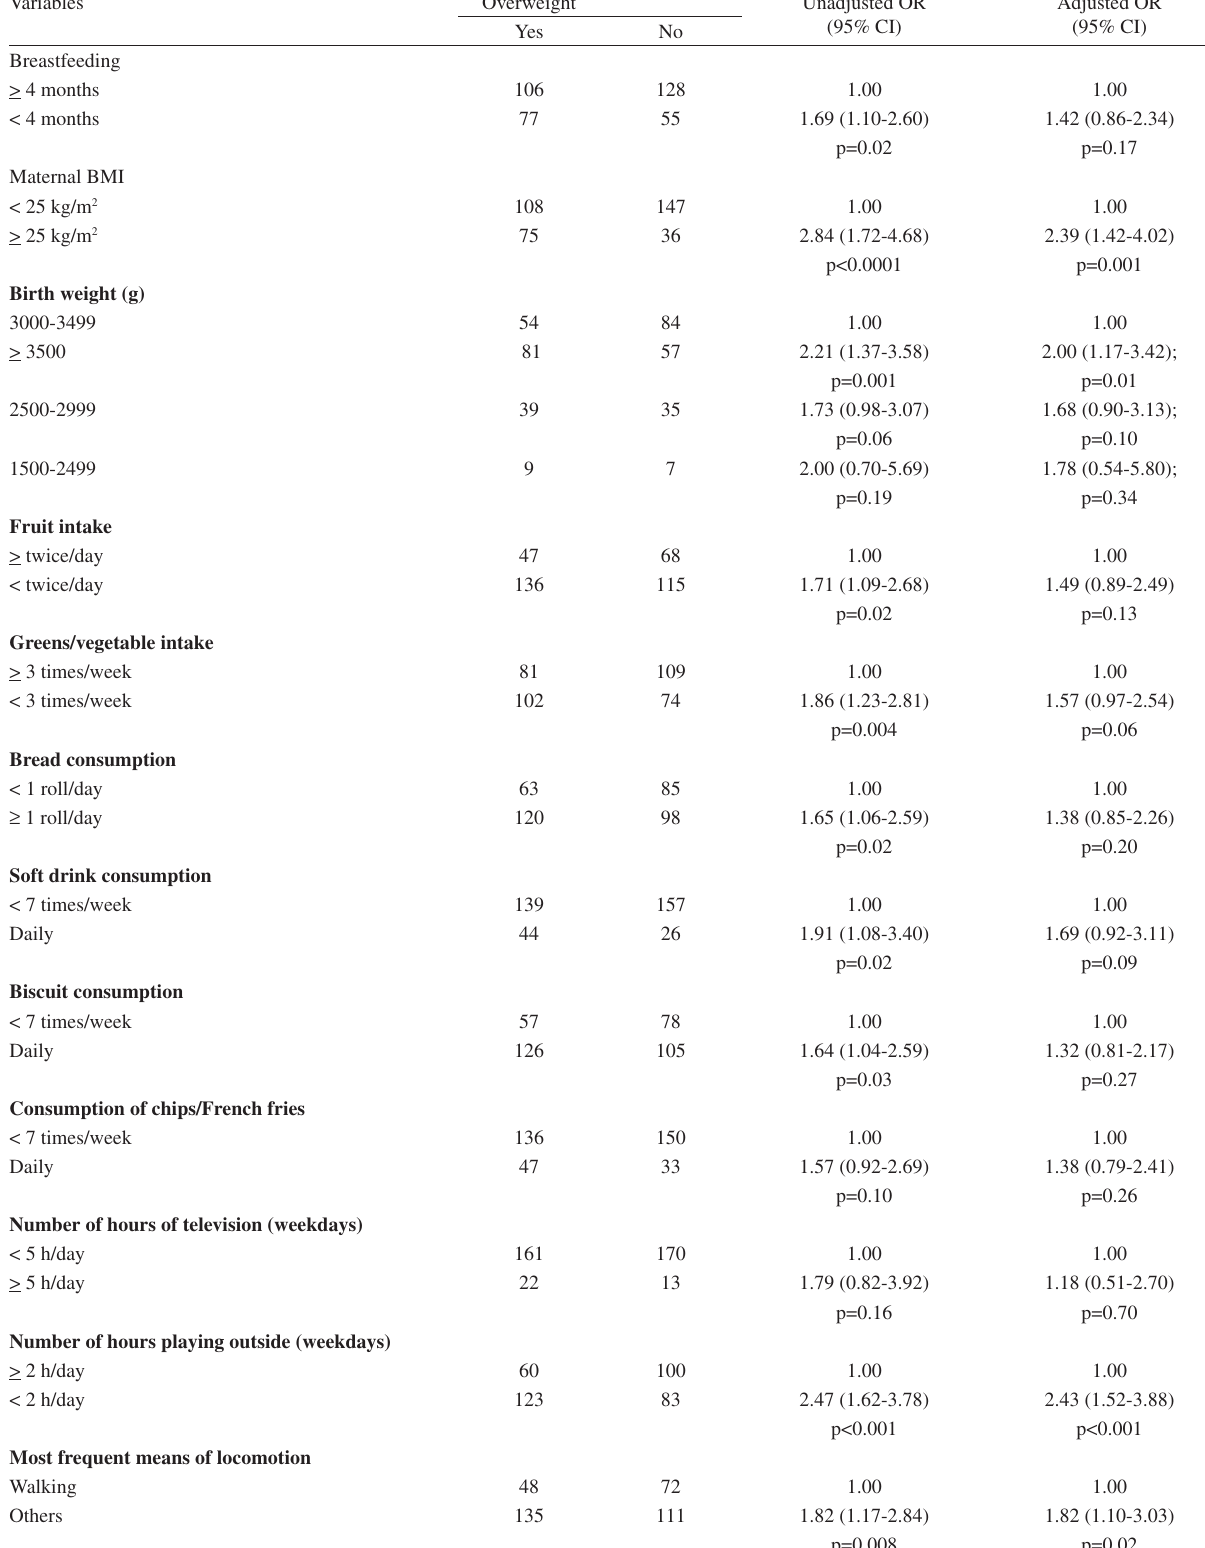
Table 2 – Logistic regression model of the risk factors for overweight among preschool children. Variables Overweight Unadjusted OR